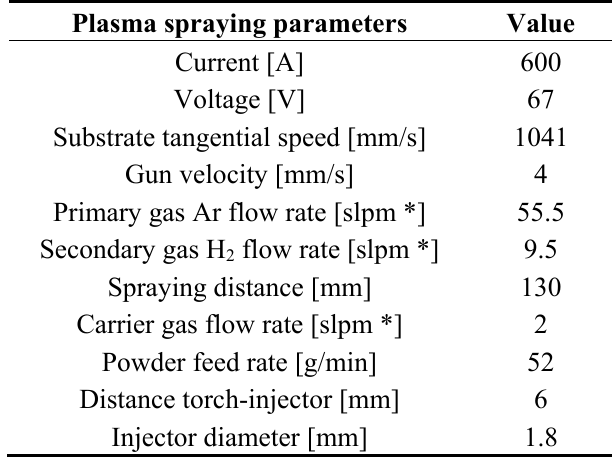
Table 1. Plasma spraying parameters used in this